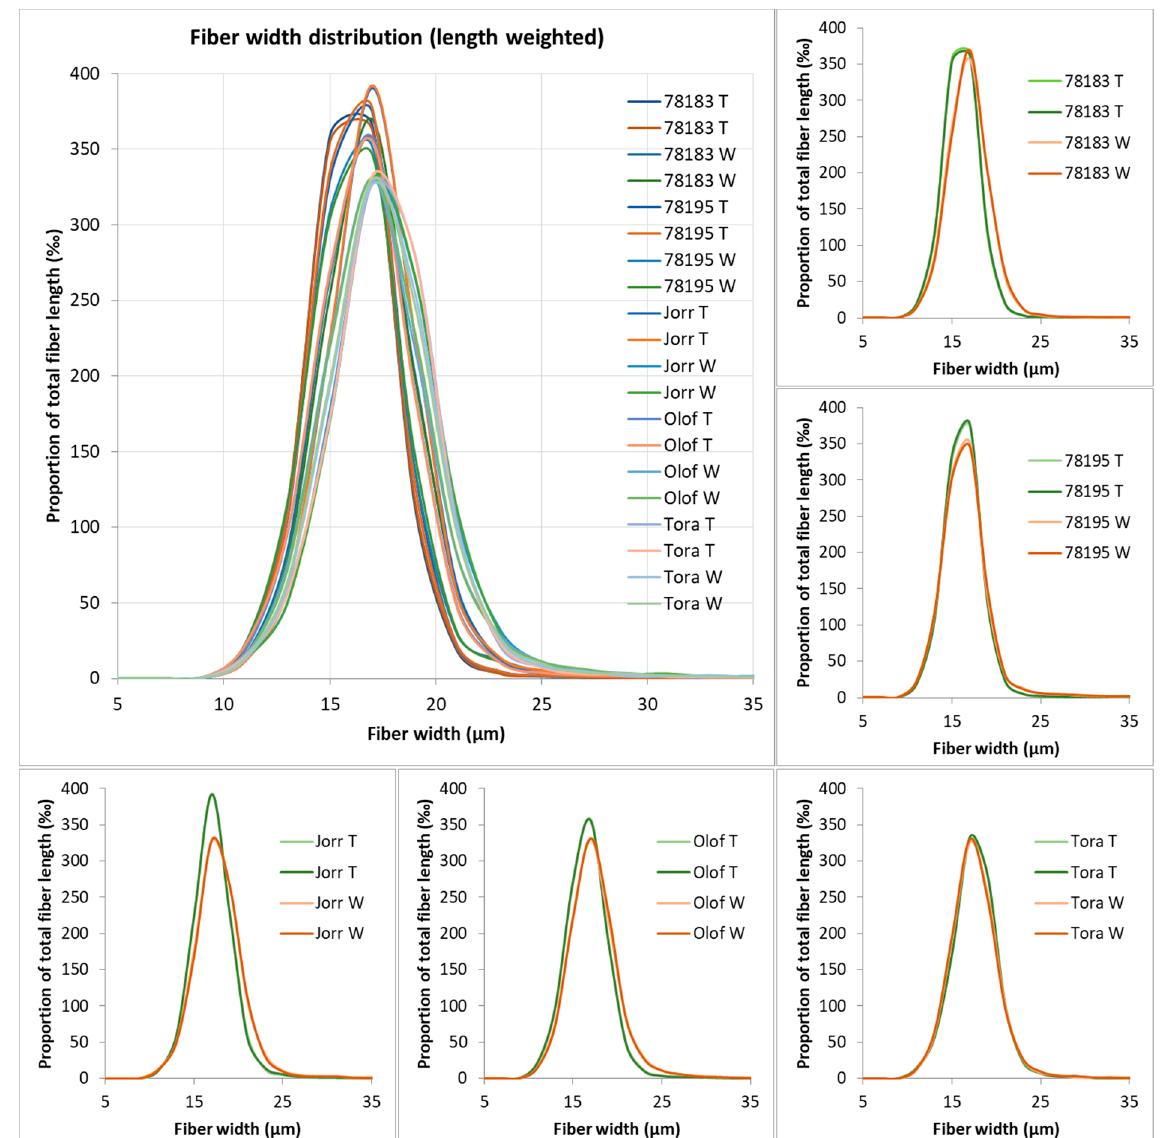
Figure 9. Fiber width distribution (length-weighted) of whole and tension wood regions from S. viminalis clones and commercial varieties.